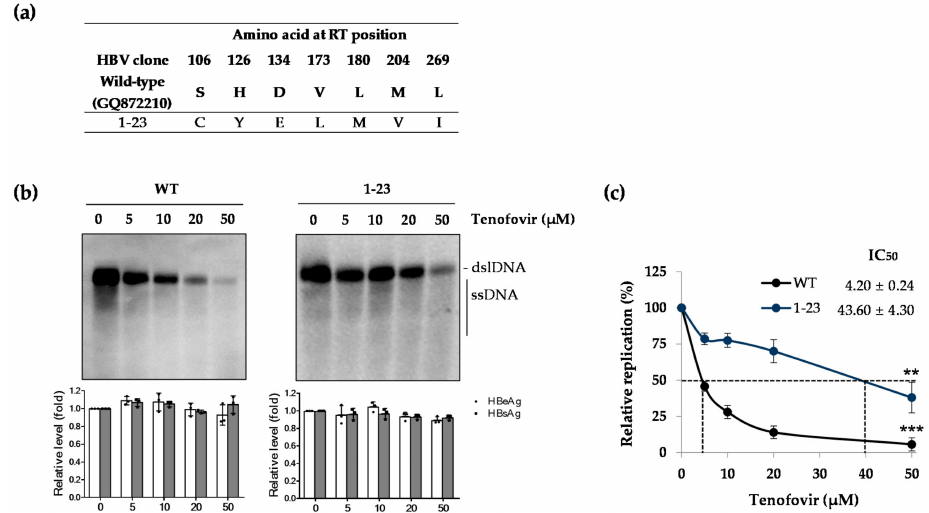
Figure 2. Replication competence and in vitro drug susceptibility of a representative patient-derived RT mutant. ( a ) Sequence of a representative RT mutant clone obtained from #1 serum of a TDF-treated patient. ( b ) In vitro tenofovir susceptibility assay of WT and Clone 1-23. The constructed HBV 1.2mer replicons were transfected into Huh7 cells, and tenofovir was administered every day in a dose-dependent manner as indicated in µ M. Four days later, the levels of HBV DNA and secreted HBeAg/HBsAg were analyzed by Southern blot and enzyme-linked immunosorbent assay (ELISA), respectively. Secreted antigen levels were assessed to confirm the transfection yield. ( c ) IC 50 values determined by Southern blot using HBV-specific digoxigenin (DIG) labeled probe in a Quantimager. ** p < 0.01; *** p < 0.001. Data in ( b , c ) were obtained from three independent experiments (mean ± SD). RT, reverse transcriptase; WT, wild-type; HBeAg, HBV e antigen; HBsAg, HBV s